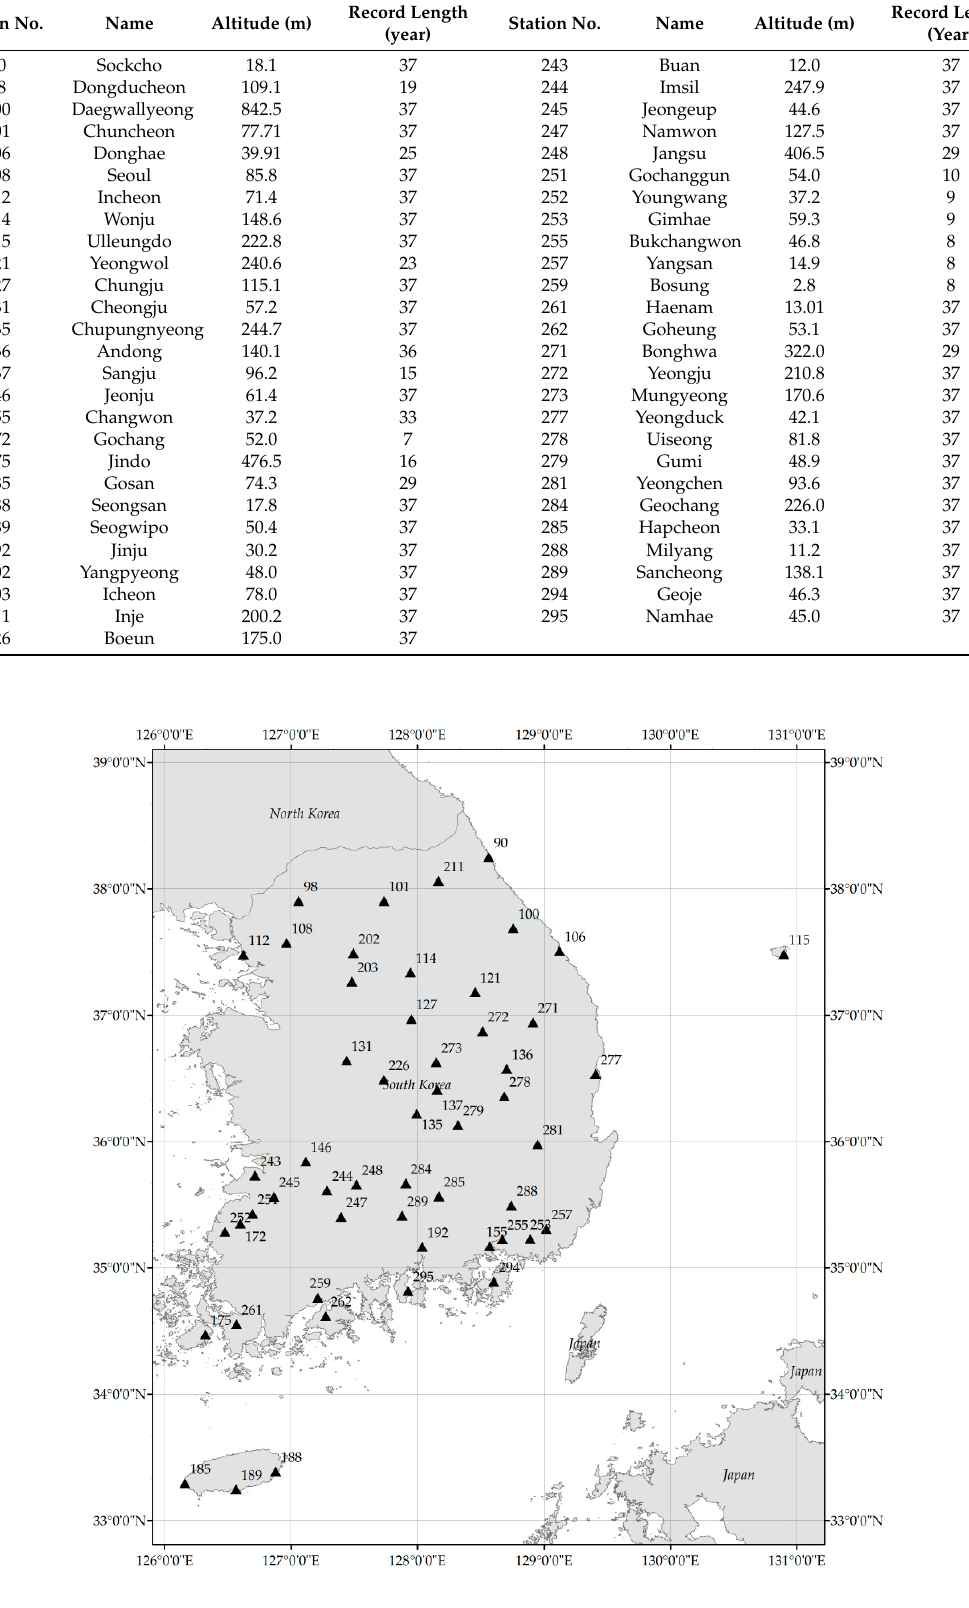
Figure 2. Geographical location of the weather stations used for hourly mean wind speed data.